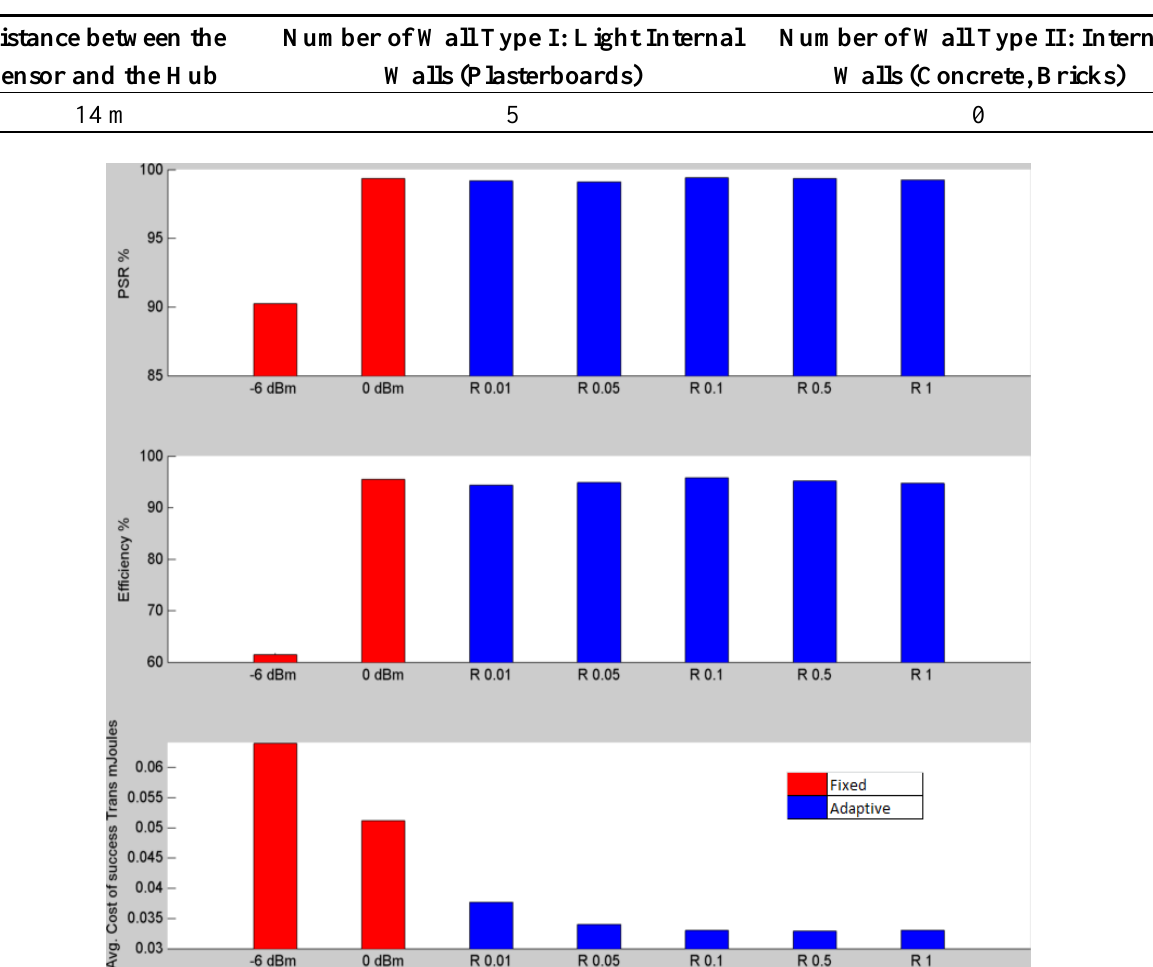
Figure 3. Comparison of the PSR, efficiency, and average cost of successful transmission when the distance between the sensor and the hub is 14 m. The minimum cost at fixed power is achieved at 0 dBm. The PSR of fixed power at 0 dBm is almost similar to the PSRs of the adaptive protocol. The adaptive protocol consumes 55% less energy than at 0 dBm when value of R is 0.5.The efficiency of the fixed power transmisison (0 dBm) is a touch higher than the adaptive protocol at R =